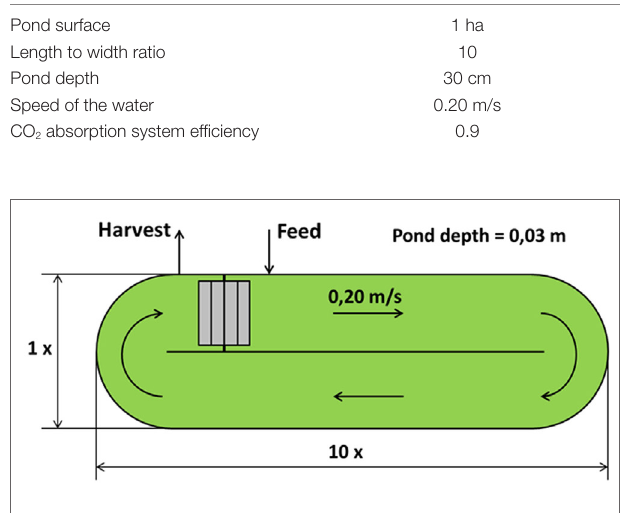
FigUre 2 | Flat panel photobioreactor .